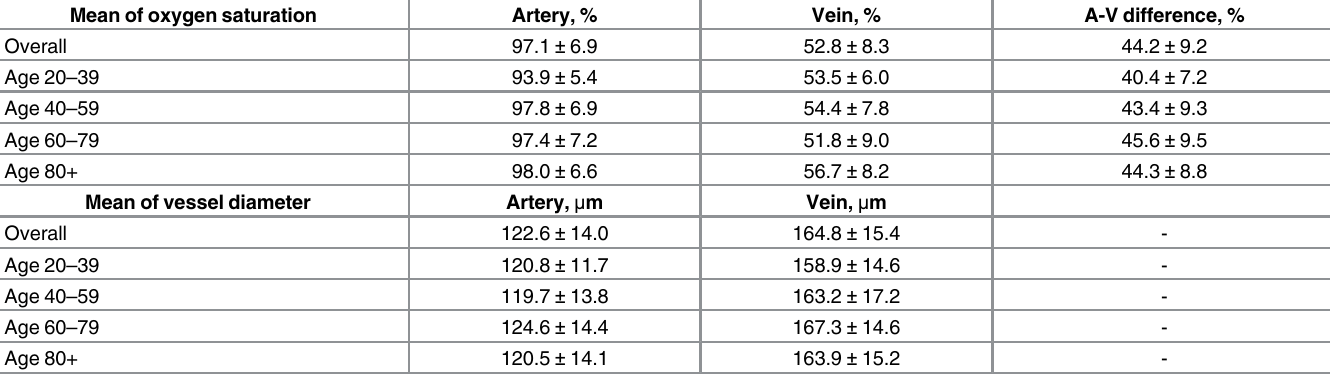
Table 3. Mean Oxygen Saturation and Mean Vessel Diameters in Major Retinal Vessels in a Healthy Japanese Population Measured using Oxymap T1. Mean of oxygen